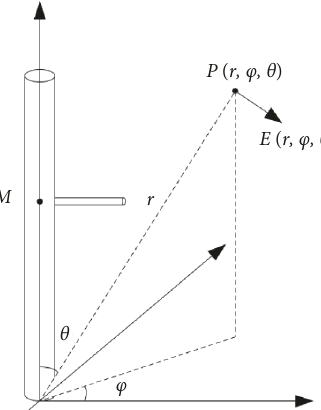
Figure 3: Schematic diagram of far-field radiation of the midload whip